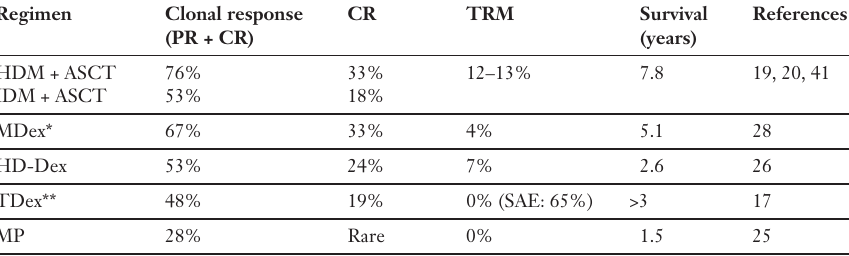
Comparison of the published effective treatments for